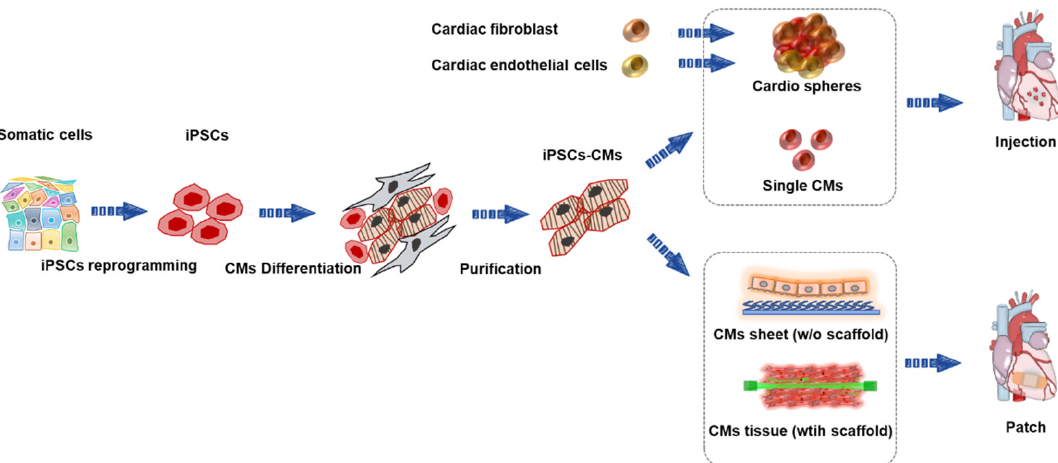
Figure 1. Overview of human induced pluripotent stem-cell-derived cardiomyocytes (iPSC-CMs) for treating heart failure. iPSCs, induced pluripotent stem cells; CMs, cardiomyocytes.